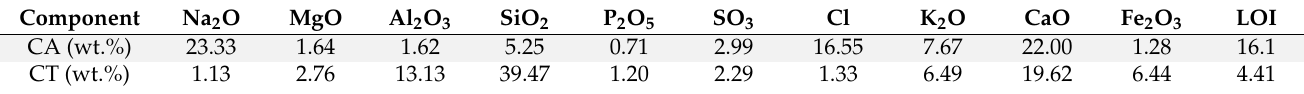
Table 4. Chemical composition and loss on ignition of CA and CT biomass fly ashes.